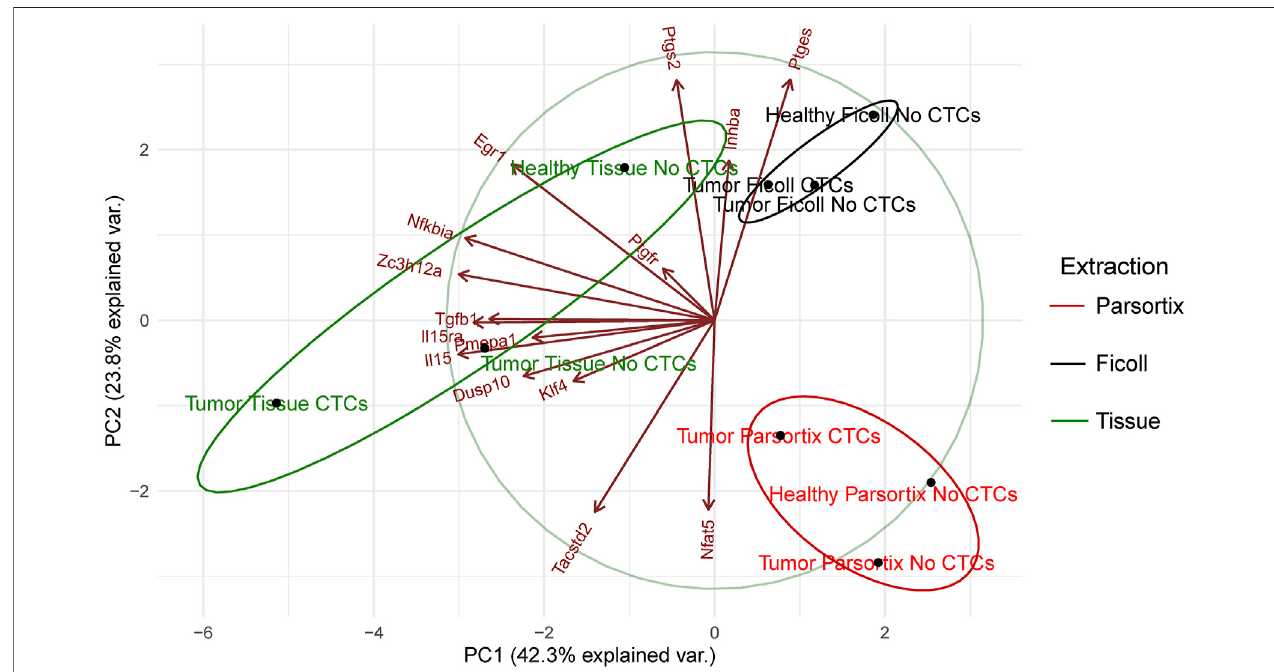
FIGURE 5 | Principal component analysis of the gene expression ( Δ Ct) data shown in Figure 4 , represented as a biplot. Sample principal component score centroids (dots) and loading of variables (vectors) are plotted. Con fi dence ellipses group samples by extraction type.